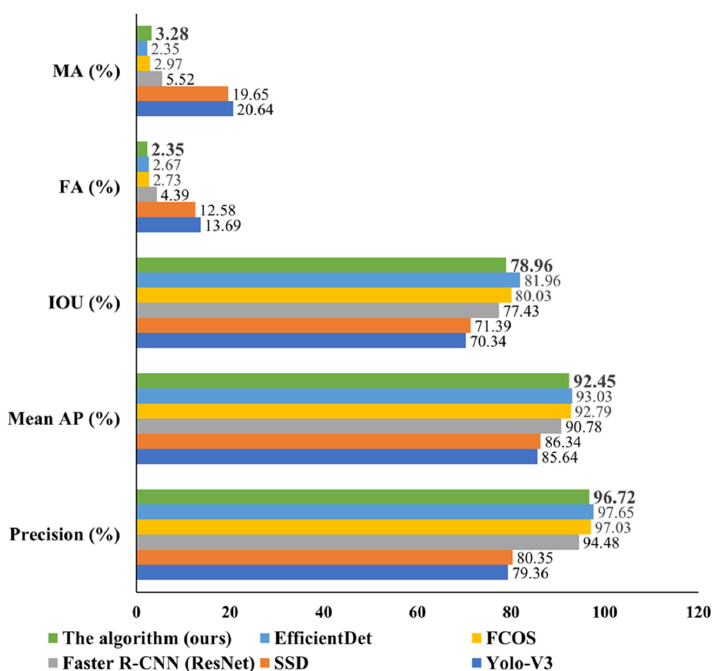
Figure 8. Detection accuracy of each algorithm.